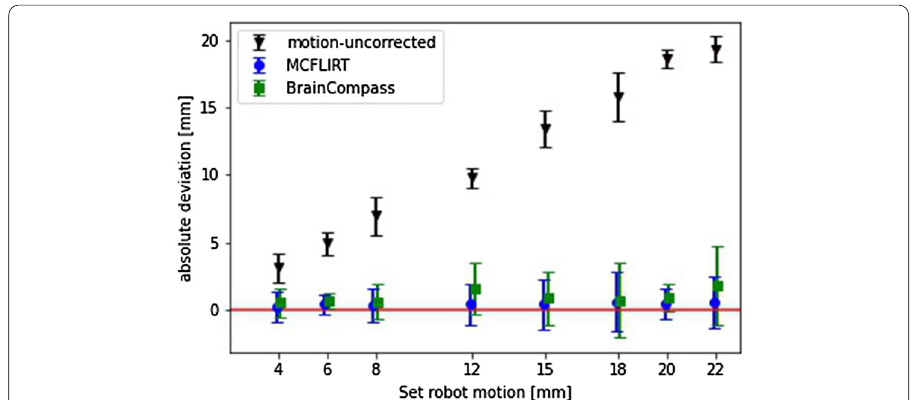
Fig. 8 Representation of the absolute deviation of the COM without any MoCo and after MoCo using BrainCompass and MCFLIRT. The red line symbolizes 0 mm distance to the COM before the motion (reference). The values represent the Euclidean distance between two points in space